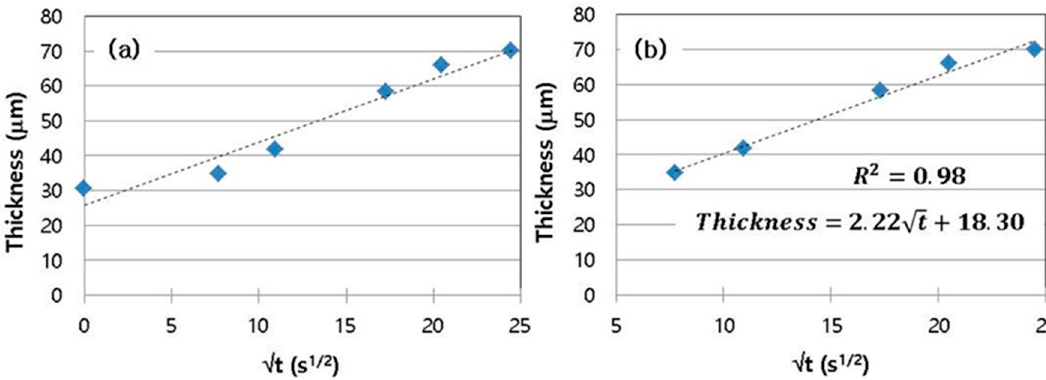
Figure 5. Thickness changes of compounds formed at the cast iron / liquid aluminum interface with heating time at 720 °C: the specimen with a holding time of 0 min is included ( a ) and not included ( b ).